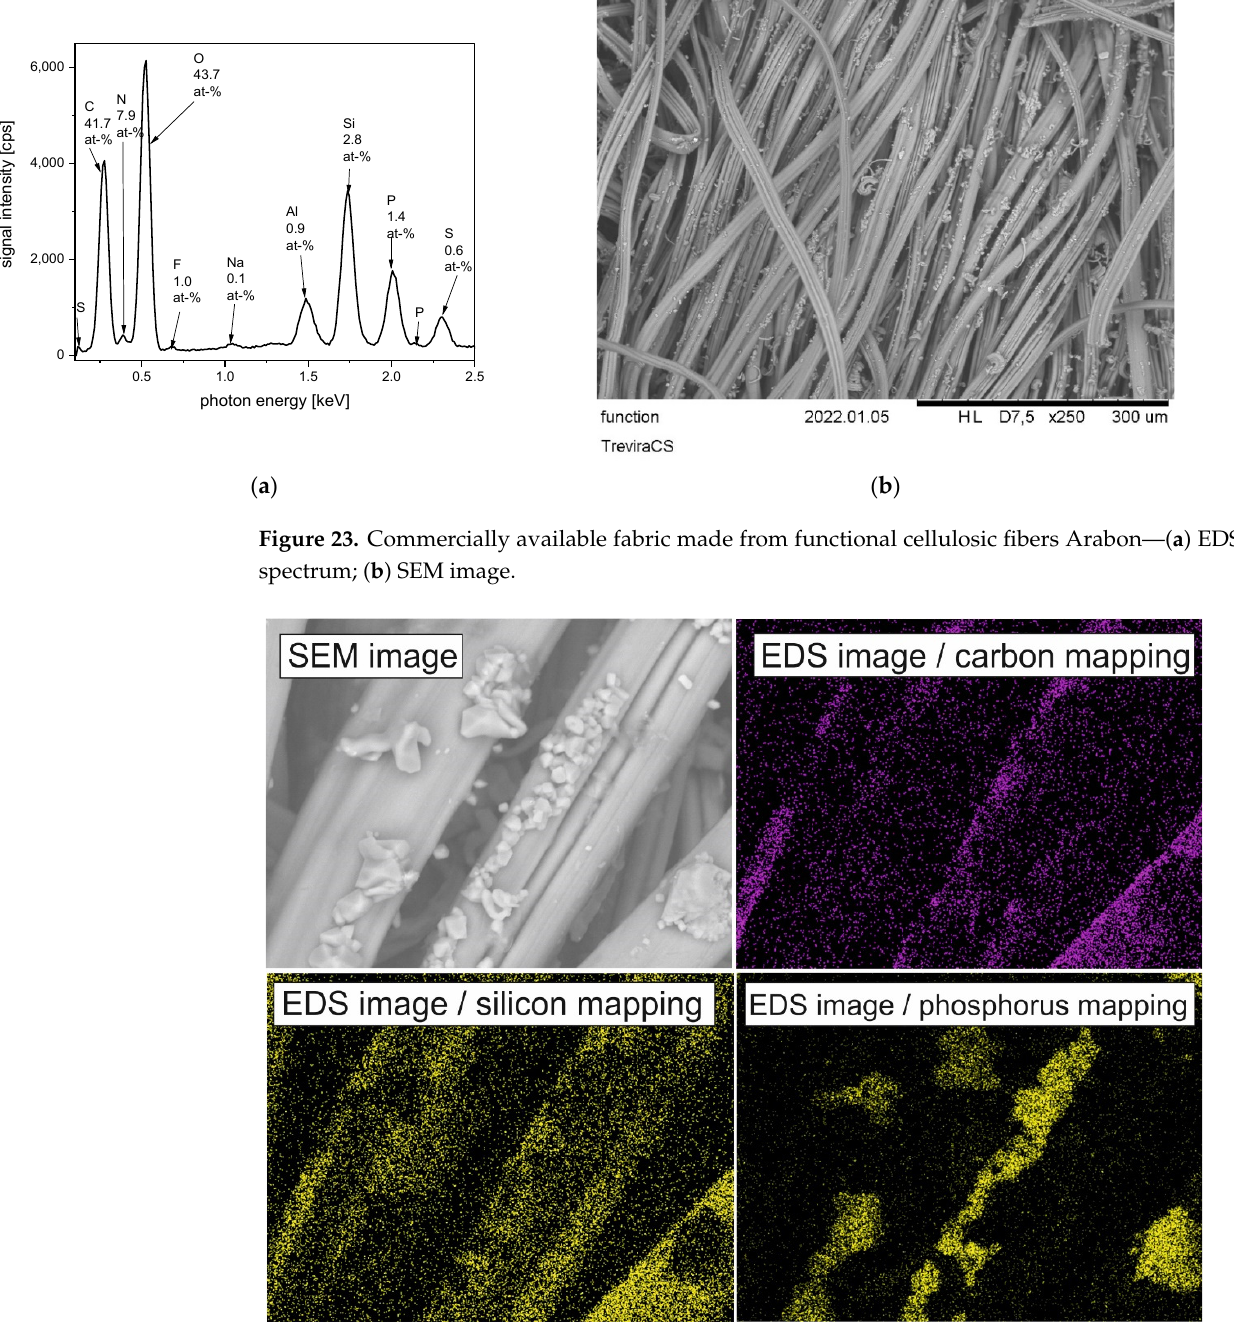
Figure 24. SEM image and related EDS images from Arabon. Compared are the mappings for the chemical elements silver and carbon. chemical elements silver and